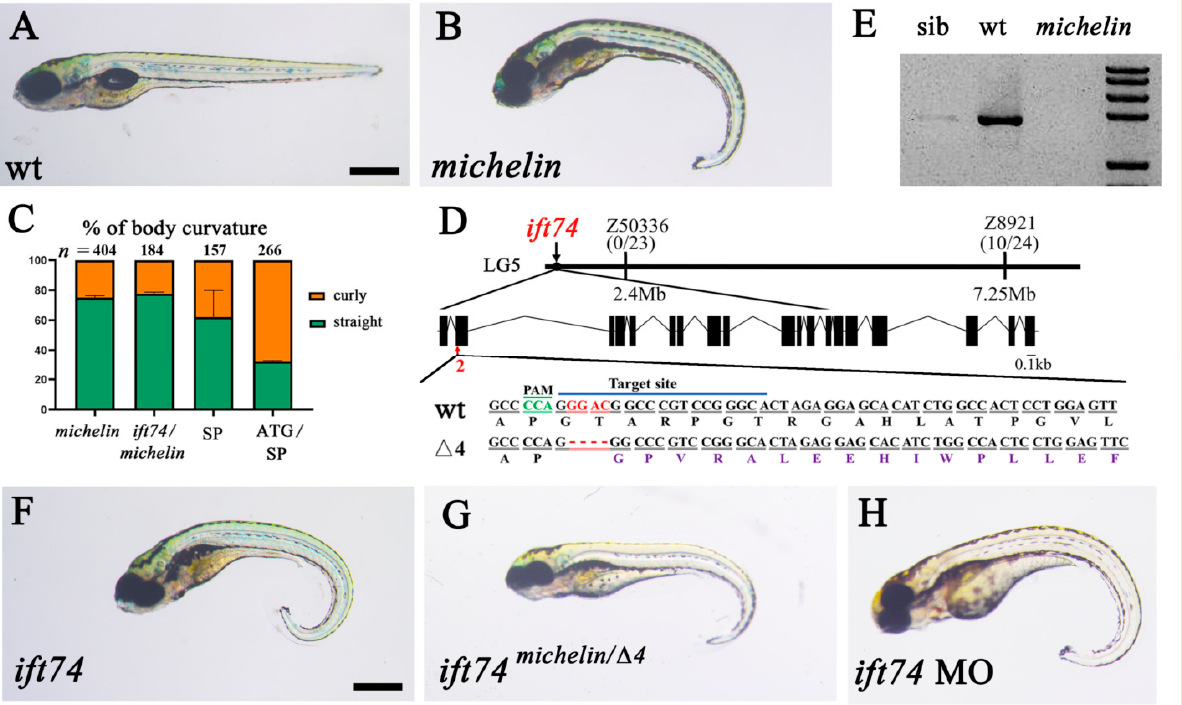
Figure 1. michelin encodes a zebrafish homolog of the ift74 gene. ( A , B ) External phenotypes of wild ‐ type (wt) and michelin mutants at 5 dpf. ( C ) Bar graph showing the percentages of embryos with body curvature defects in different groups as indicated. SP, splicing morpholino; ATG, translation ‐ blocking morpholino. ( D ) Genetic map on LG 5 showing the number of recombinants near michelin/ift74 locus. The exon/intron structure of the ift74 transcript was shown in the middle. Bottom showing the sequence of wild ‐ type and ift74 mutants generated with CRISPR/Cas9 methods. The sgRNA targeting site was indicated with overline, the PAM site was labeled in green and the changing bases in the target region were shown in red. ( E ) PCR analysis showing the amplification of ift74 ORF in 3 dpf wild ‐ type, sibling, and michelin mutant larvae. ( F – H ) External phenotypes of 5 dpf ift74 mutant and morphant larvae as indicated. Scale bars: 500 μ m.